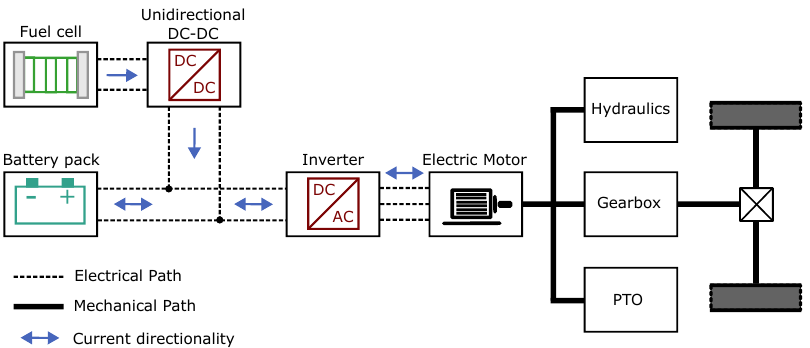
Figure 7. Schematic representation of the hybrid fuel cell/battery powertrain.